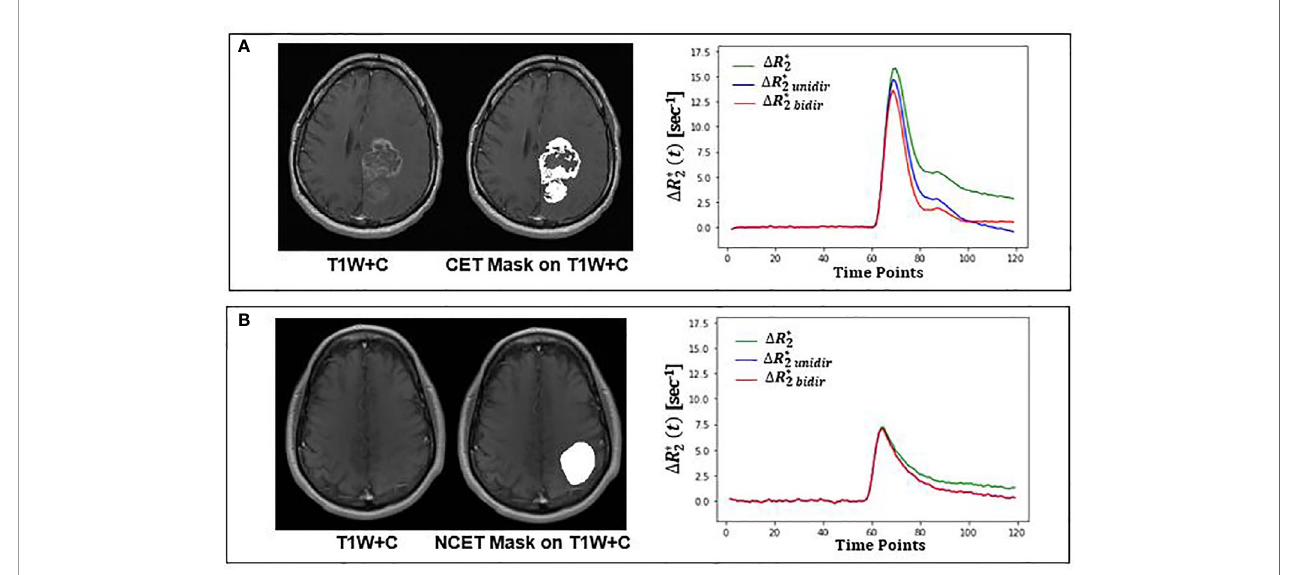
FIGURE 2 | Leakage correction effect on relaxivity-time curve for an enhancing (top) and nonenhancing (bottom) tumor from TCIA dataset. (A) Structural T 1 - weighted postcontrast (T1W+C) image overlaid with CET VOI on the left; mean uncorrected (green), bidirectional (red) and unidirectional (blue) corrected relaxivity- time in CET VOI on the right. (B) Structural T 1 -weighted postcontrast (T1W+C) image overlaid with NCET VOI on the left; mean uncorrected (green), bidirectional (red) and unidirectional (blue) corrected relaxivity-time in NCET VOI on the right. CET, Contrast Enhanced Tumor, NCET, Non Contrast Enhanced